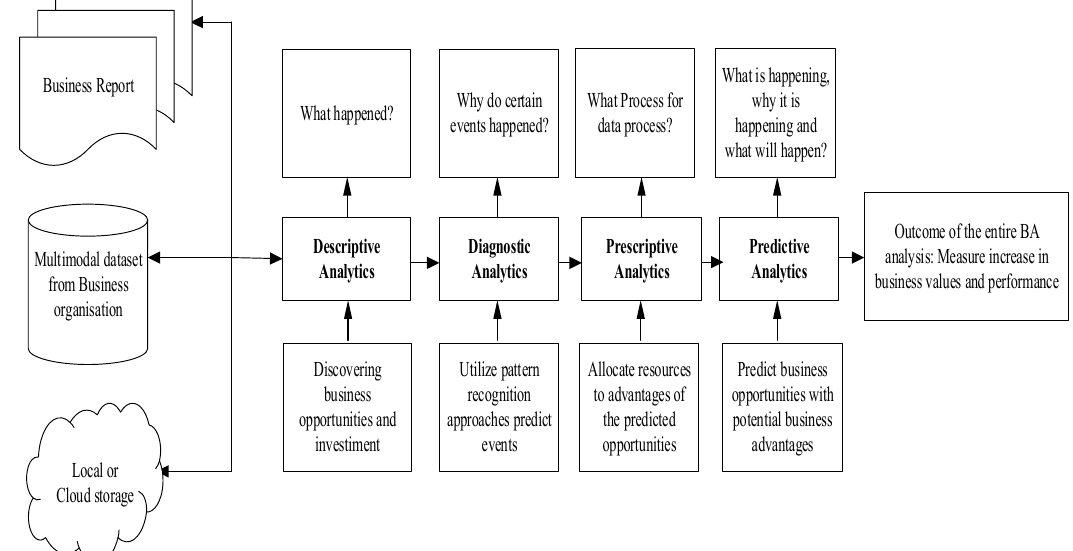
Figure 3. Business analytics process.